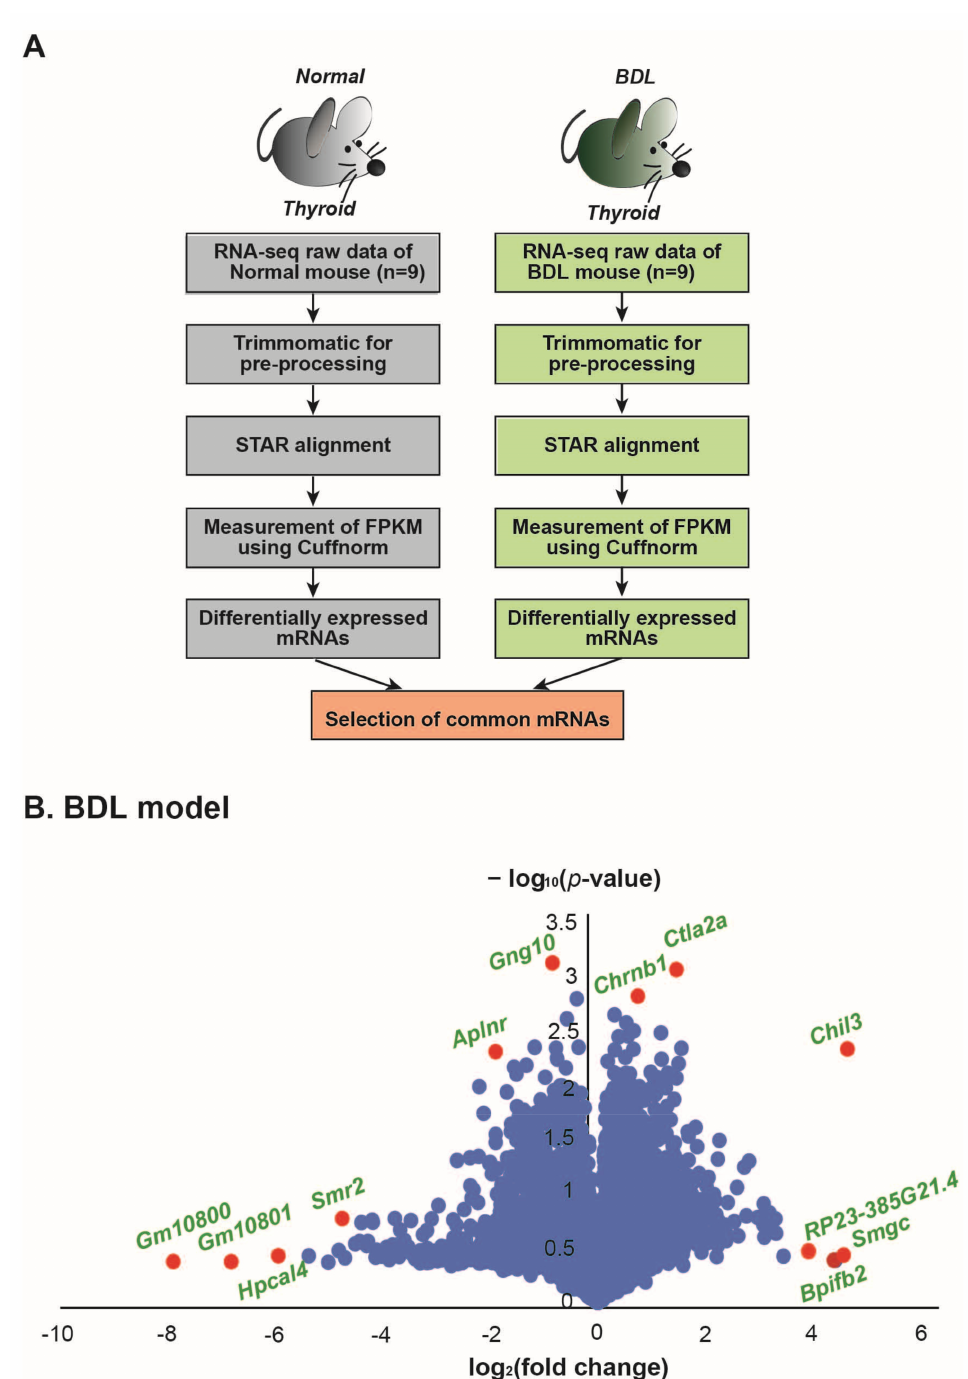
Figure 1. Analysis of transcriptomic data from the thyroid gland tissue of BDL mouse models. ( A ) Process for analysis of the transcriptome data. ( B ) Volcano plots of the BDL mouse model. The X-axis showed the log 2 -transformed fold change in each group and the Y-axis represents the − log 10 ( p -value) value. Red dots indicate the genes with a significantly changed